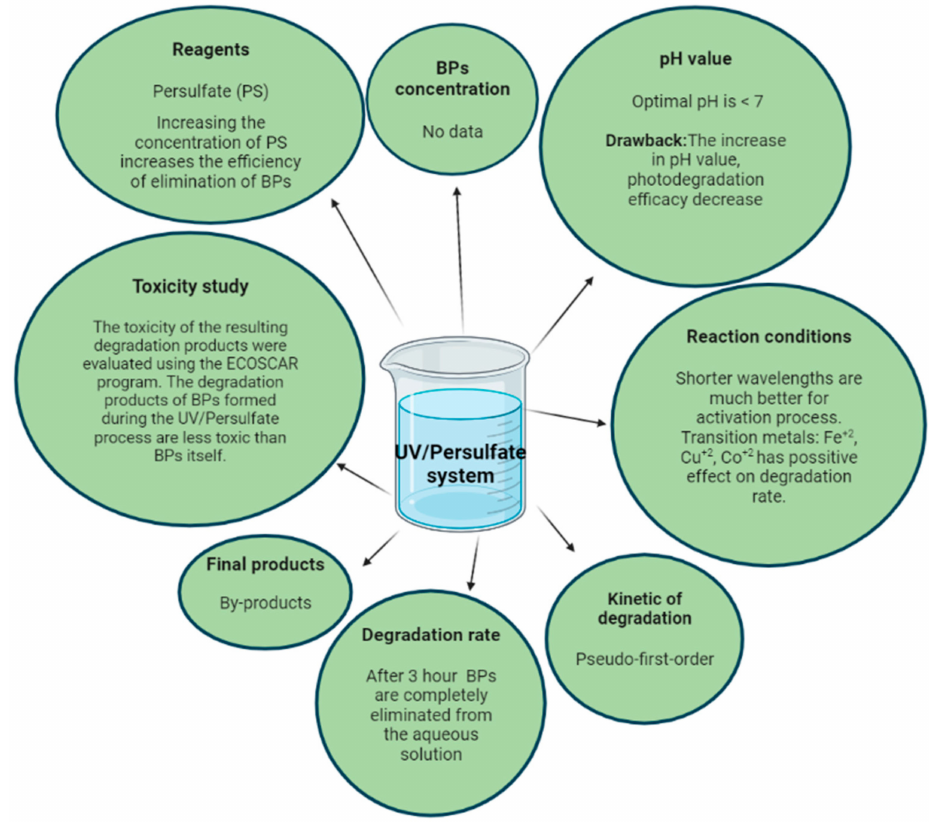
Figure 5. An overview of the effect of different conditions in the UV/persulfate process on the degradation process of BPs. Created in